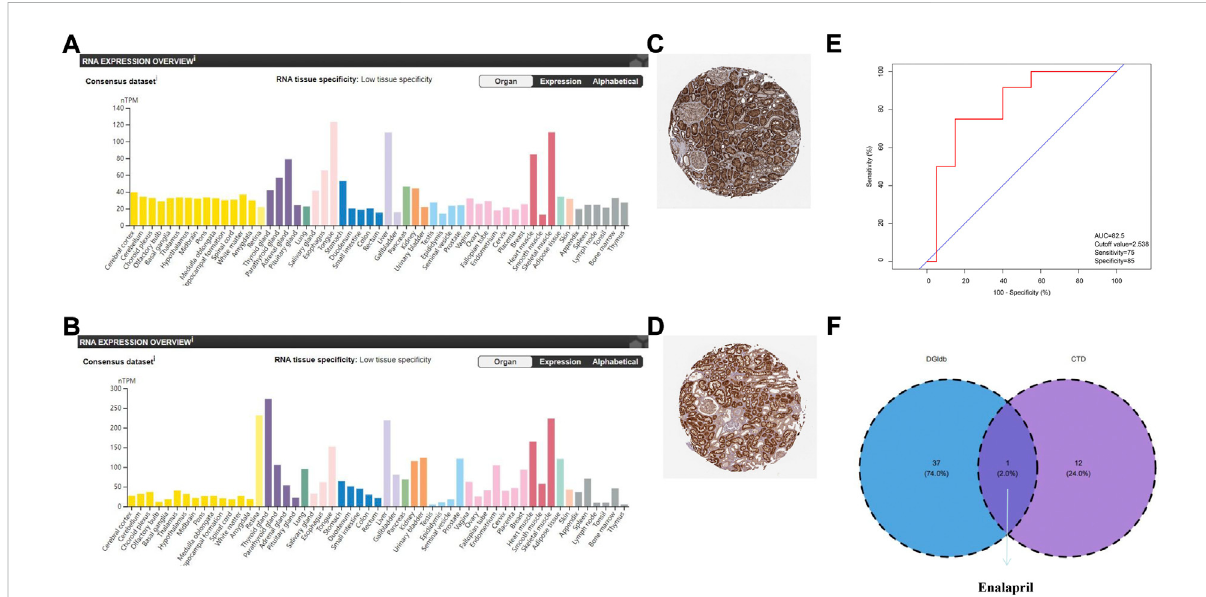
FIGURE 9 Veri fi cationoftheexpressionofkeyhubgenesinhumans,diagnosticvalueof Vegfa ,andpredictionofpotentialdrugs. (A) Expressionof Bckdha in normal kidney tissues. The orange module showed that Bckdha was moderately expressed in normal kidneys. (B) Expression of Vegfa in normal kidney tissues. The orange module showed that Vegfa was moderately expressed in normal kidney. (C) Immunohistochemical staining showed that Bckdha was highly expressed in normal kidney tissues. (D) Immunohistochemical staining showed that Vegfa was highly expressed in normal kidney tissues. (A – D) Diagrams were downloaded from the Human Protein Atlas, available online (http://www.proteinatlas.org). (E) Diagnostic value of Vegfa in the validation set of the GSE66494 dataset. (F) Venn diagram of drug prediction results of Vegfa . AUC, area under the curve; DGIdb, Drug – Gene Interaction database; CTD, Comparative Toxicogenomics Database.